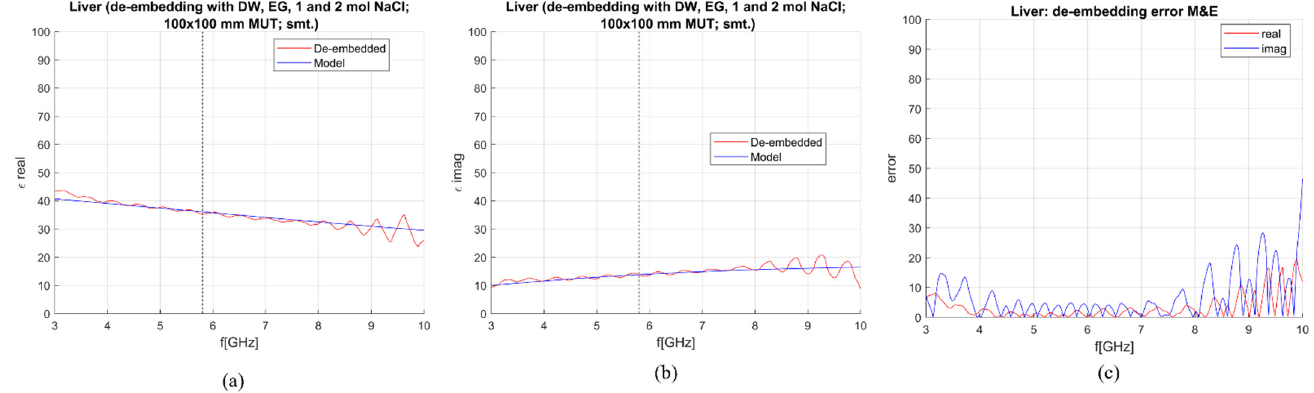
Figure 13. M&E de-embedding with 2nd calibration option: DW, EG70, 1 mol and 2 mol NaCl (smoothing applied): ( a ) Calculated vs. reference ε ’; ( b ) Calculated vs. reference ε ’’; ( c ) Sensitivity (de-embedding error) for ε ’ (“real”) and ε ’’ (“imag”).